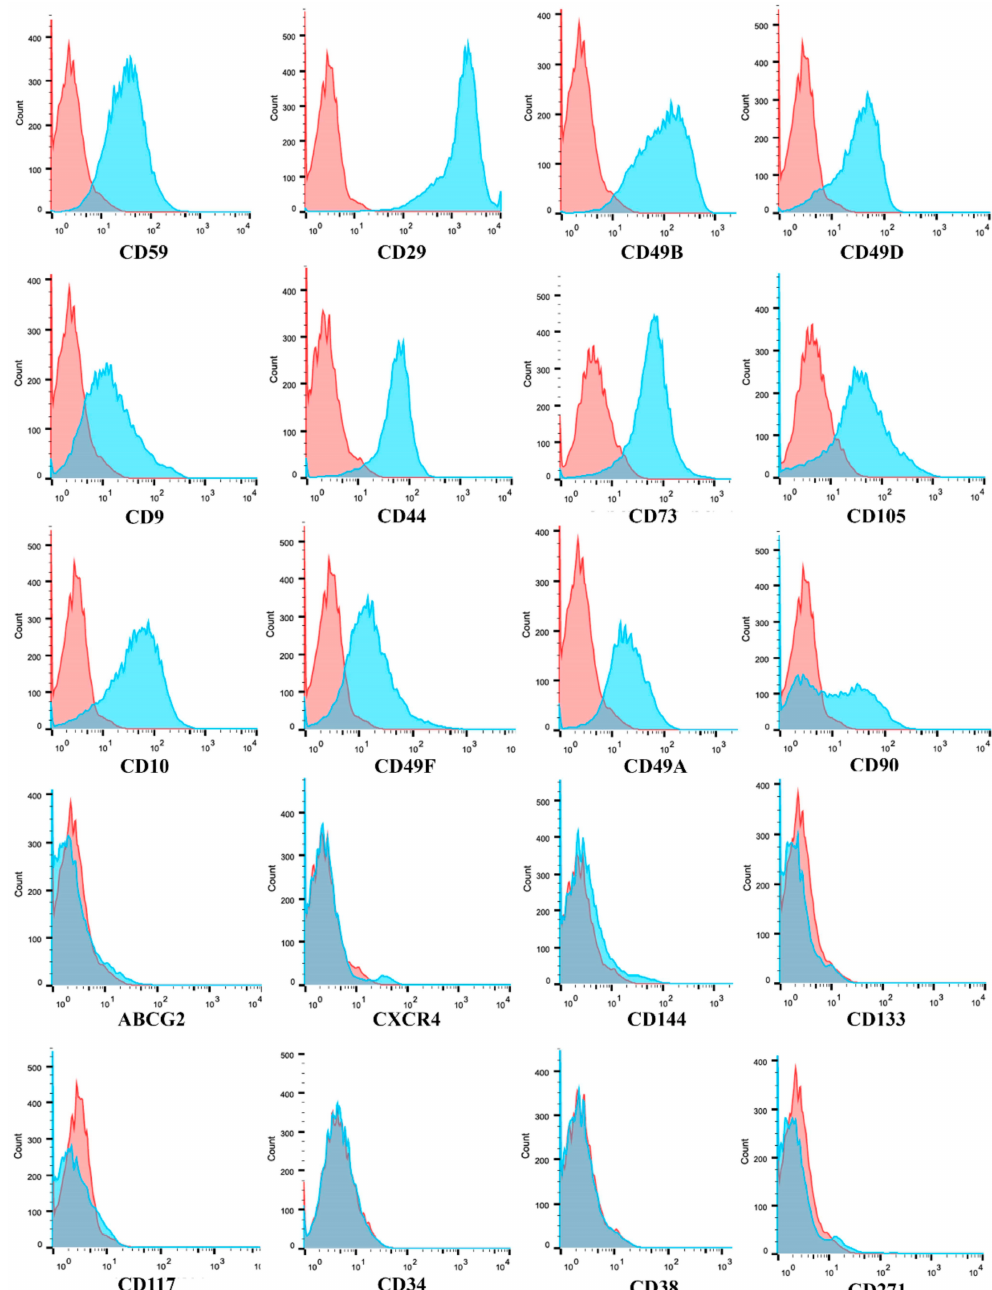
Figure 3. GASC-ALA + , ALA PALE, ALA − share the same mesenchymal stem cell immunophenotype. Representative histograms of the flow cytometry analysis of GASC cell populations. Histogram overlays show isotype control IgG staining profile (red histogram) versus the specific antibody staining profile (cyan histogram). The expression of twenty surface antigens was evaluated using the flow cytometer FACS CANTO II (BD Biosciences). See Table 1 for quantitative data. Our data suggest that GASC, regardless their distance from the tumor core, share similar phenotypic properties. Importantly, independently from the region of origin, no major di ff erences were seen among GASC isolated from the six GBM